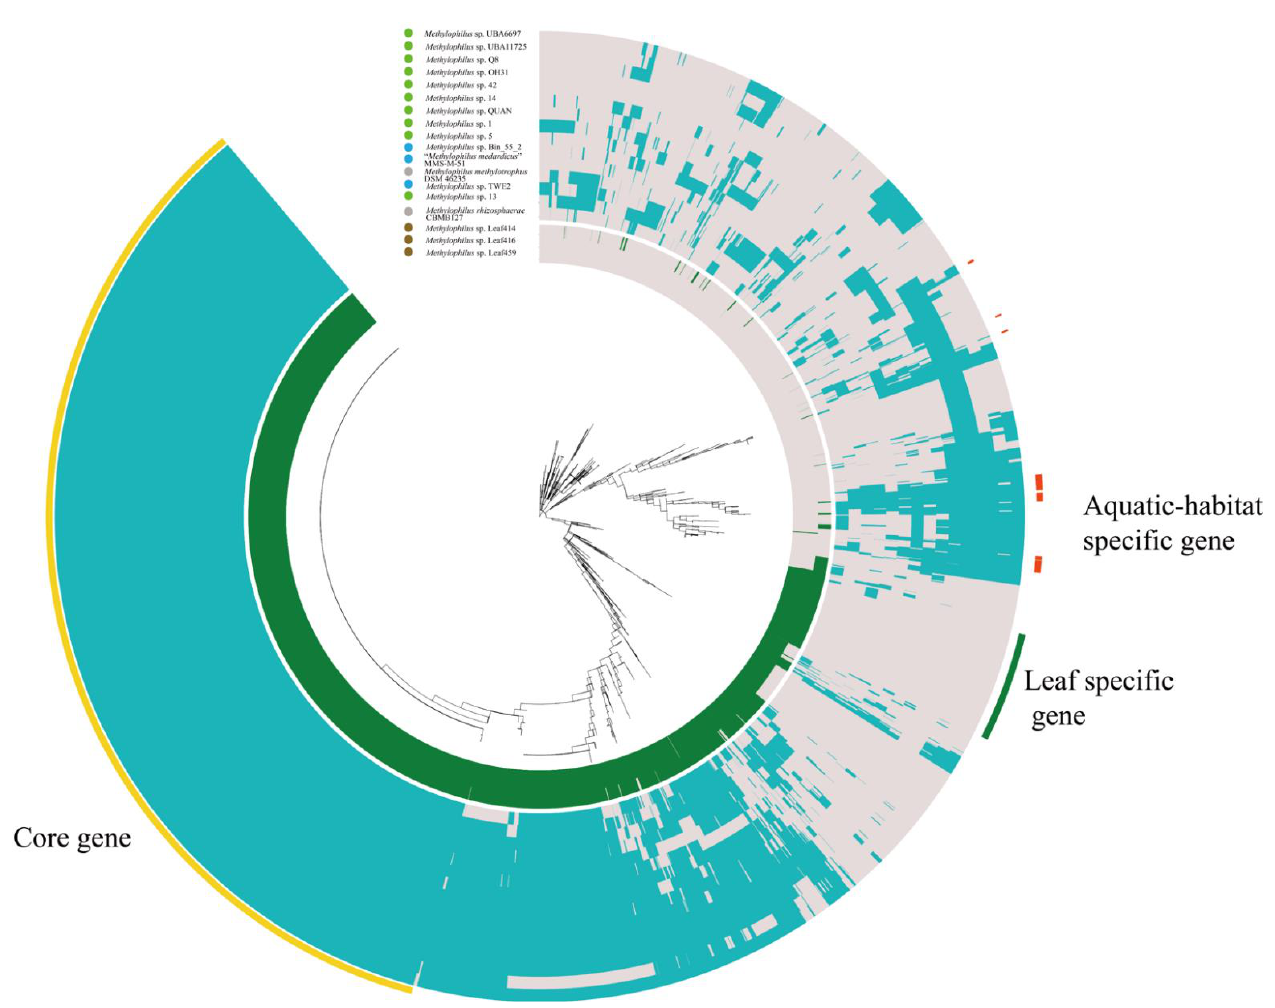
Figure 4. Orthology analysis. Clustering of genomes based on the presence/absence patterns of 3994 orthologous clusters. Genomes of strains isolated from leaf and aquatic habitats (water and sediment) were colored with green and blue in the gene heatmap. Eighteen genomes were defined by the gene tree in the center, and they were organized in radial layers as aquatic-habitat specific gene, leaf specific gene and core gene, which were colored with red, green and yellow. The solid circles with colors, blue, brown, green and grey, represent isolation sources, water, leaf, sediment and others, respectively.